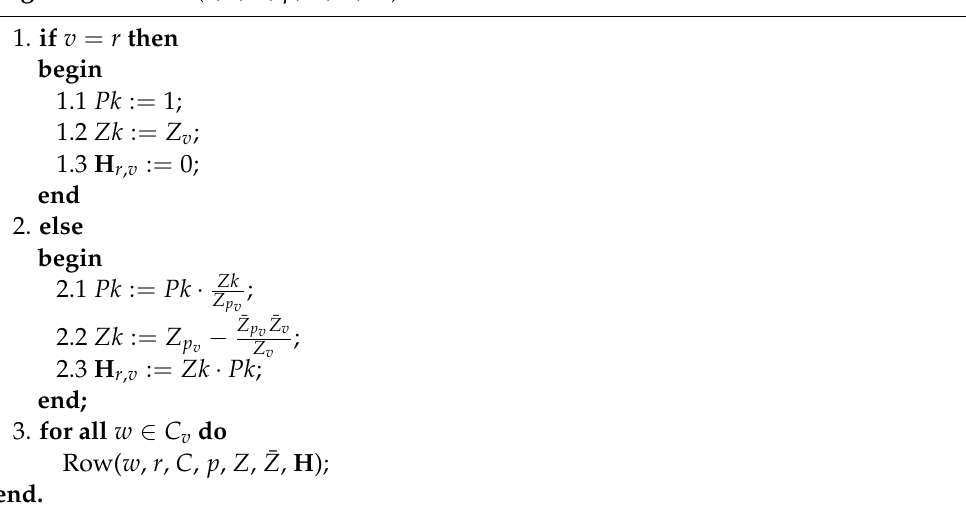
Algorithm 3. Row( v , r , C , p , Z , ¯ Z , H